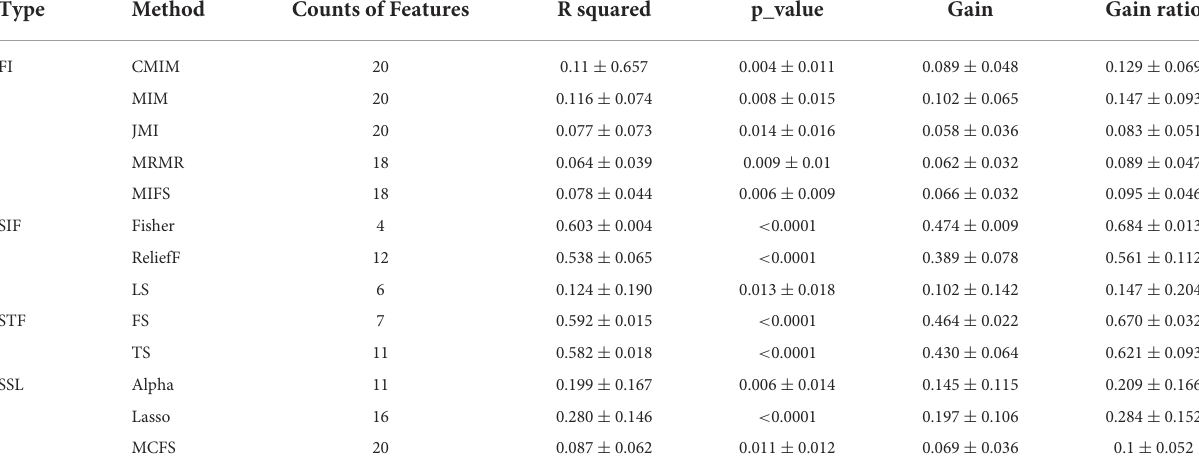
TABLE 5 The counts of features and four attributes of 13 F method